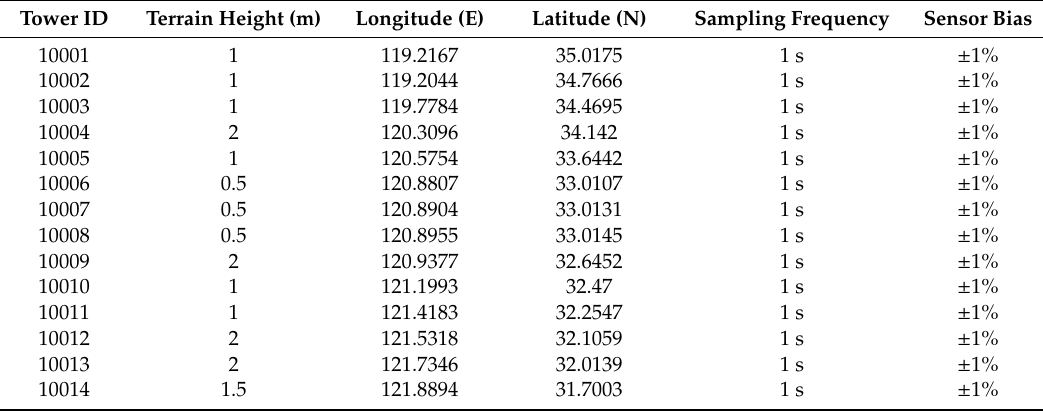
Table 2. Wind observation tower locations, terrain height, and sensor